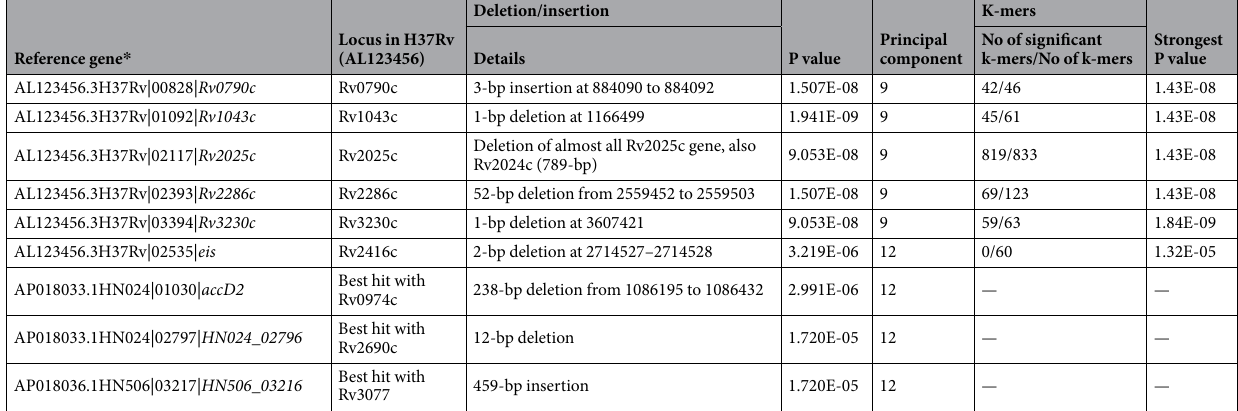
Table 4. Genes with deletions/insertions significantly associated with clustered strains harboring katG -S315T mutation among Hanoi samples obtained by GWAS, and corresponding k-mers. PC-9 correlated gene variants were observed in 14 samples (HN-042, HN-065, HN-120, HN-127, HN-152, HN-154, HN-170, HN-179, HN- 186, HN-222, HN-253, HN-391, HN-441, HN-456) that belong to ancient Beijing sublineages. PC-12 correlated gene variants were observed in 10 samples (HN-019, HN-075, HN-109, HN-137, HN-169, HN-324, HN-330, HN-435, HN-462, HN-506) that belong to modern Beijing sublineages. * Genome sequences of clinical isolates in our Hanoi cohort, AP018033 to AP018036 as well as AL123456 (H37Rv genome) were used for reference.